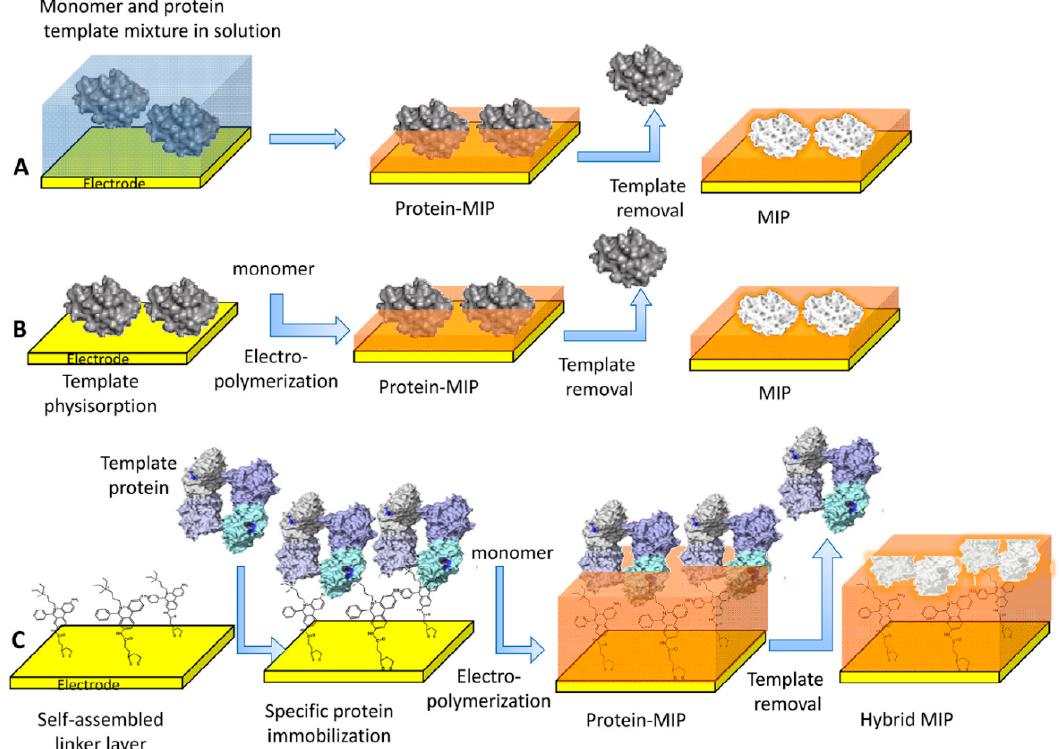
Figure 12. Sketches of various surface imprinting methodologies for the electrosynthesis of MIP films for selective recognition of proteins: electropolymerization of a mixture of protein and monomer in solution ( A ); preconcentration of the protein (peptide in case of epitope imprinting) on the surface of an electrode either by physisorption ( B ) or by using a self-assembled anchor layer for oriented immobilization of the protein (e.g., a weak inhibitor of an enzyme) ( C ). Image reproduced from [110] with permission.